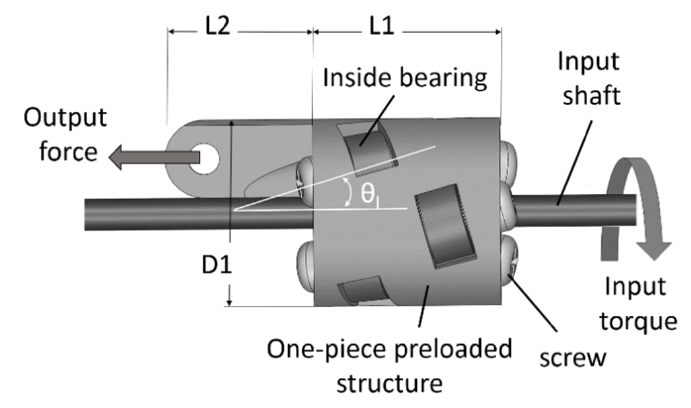
Figure 9. The illustration of the designed TLBS while operating. Table 3. Accuracy of manufactured TLBS.